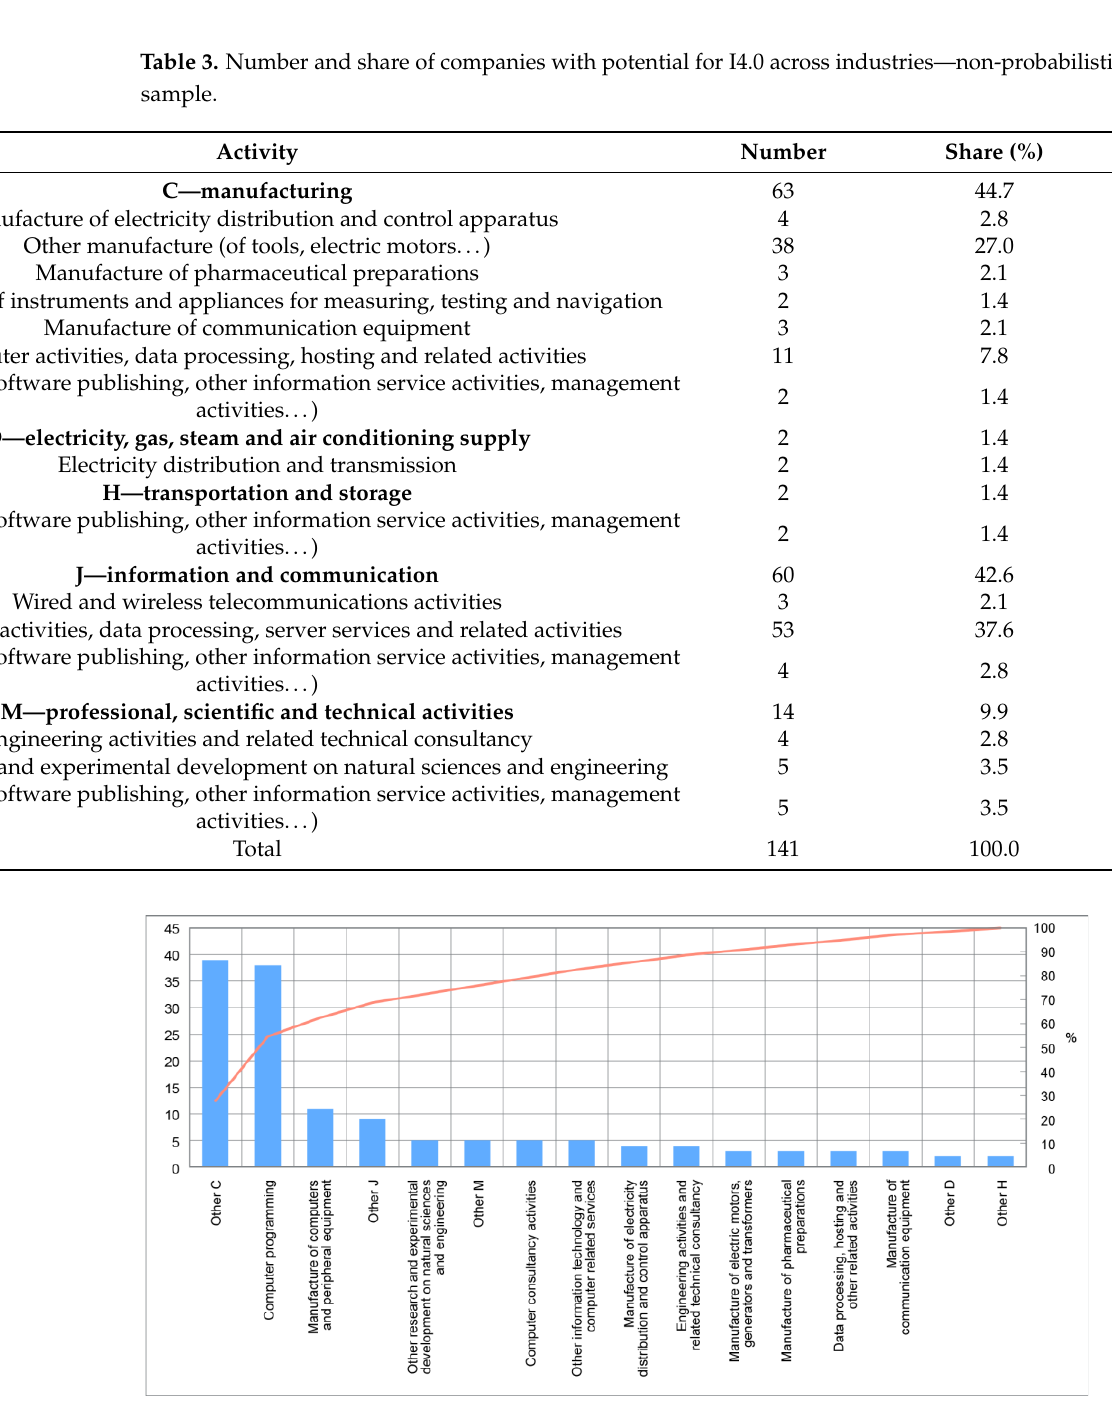
company size. The share of small enterprises (52%) in the potentials of the group is the greatest, while medium-sized (25%) and large-scale enterprises (23%) account for similar